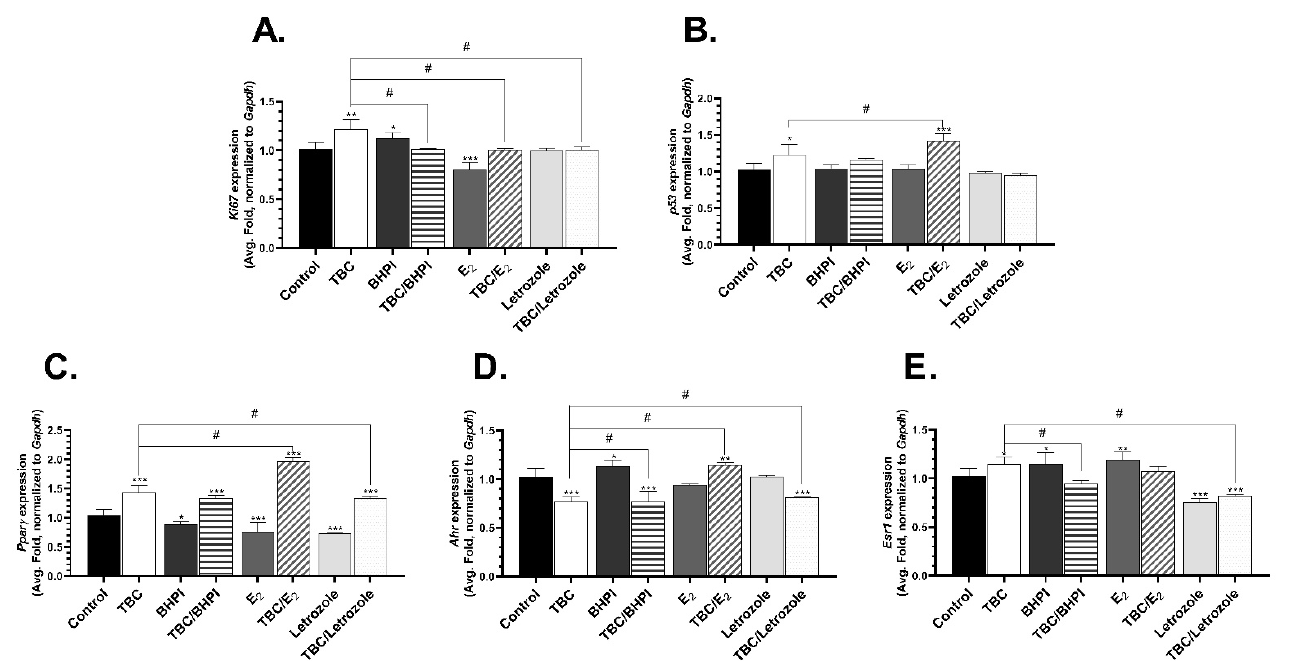
Figure 3. Effect of 10 µ M TBC and TBC in the cotreatment (BHPI—10 µ M, E 2 —100 nM, letrozole—1 µ M) on the Ki67 ( A ), p53 ( B ), Ppar γ ( C ), Ahr ( D ), Esr1 ( E ), and Gapdh mRNA expression in the GC‑1 spg cells after 48 h exposure. The mRNA expression was normalized to Gapdh . Data are expressed as means ± SD of three independent experiments, each conducted in six replicates per treatment group. * p < 0.05, ** p < 0.01, *** p < 0.001 vs. the vehicle control; # p < 0.05 vs. cells treated by TBC alone.